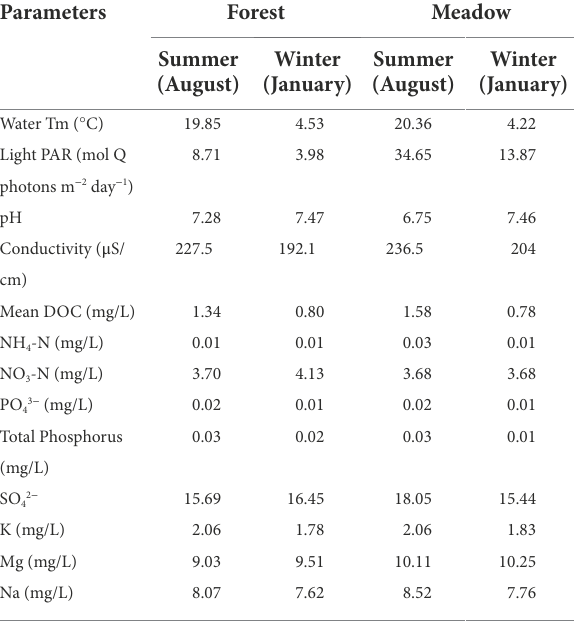
TABLE 1 Environmental measurements (monthly average) for forest and meadow reach in summer and winter. Parameters Forest